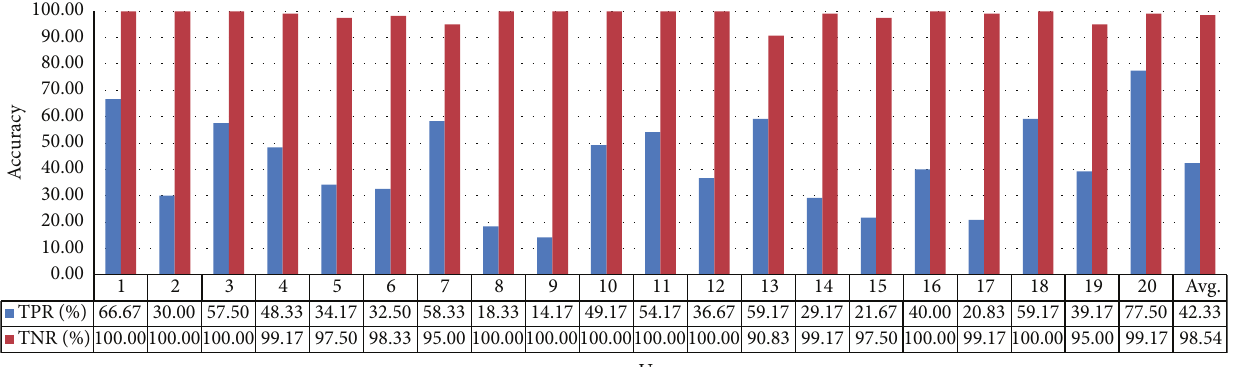
Figure 21: Accuracy of selecting the air conditioner switch using gaze estimation method 1.